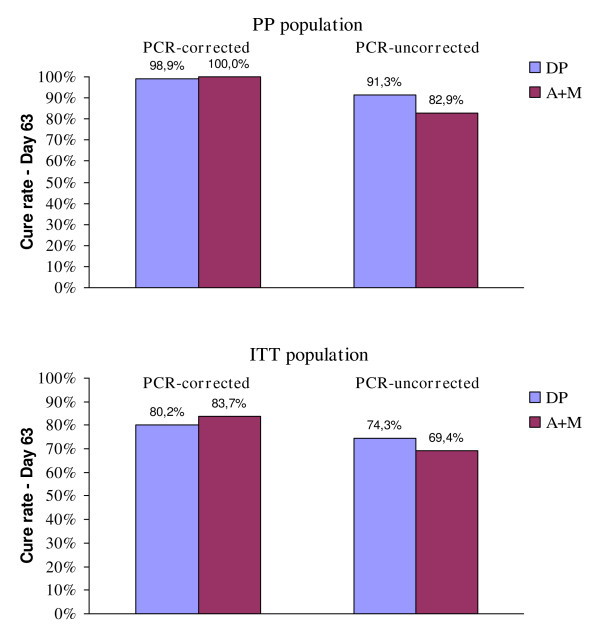
Treatment outcome.